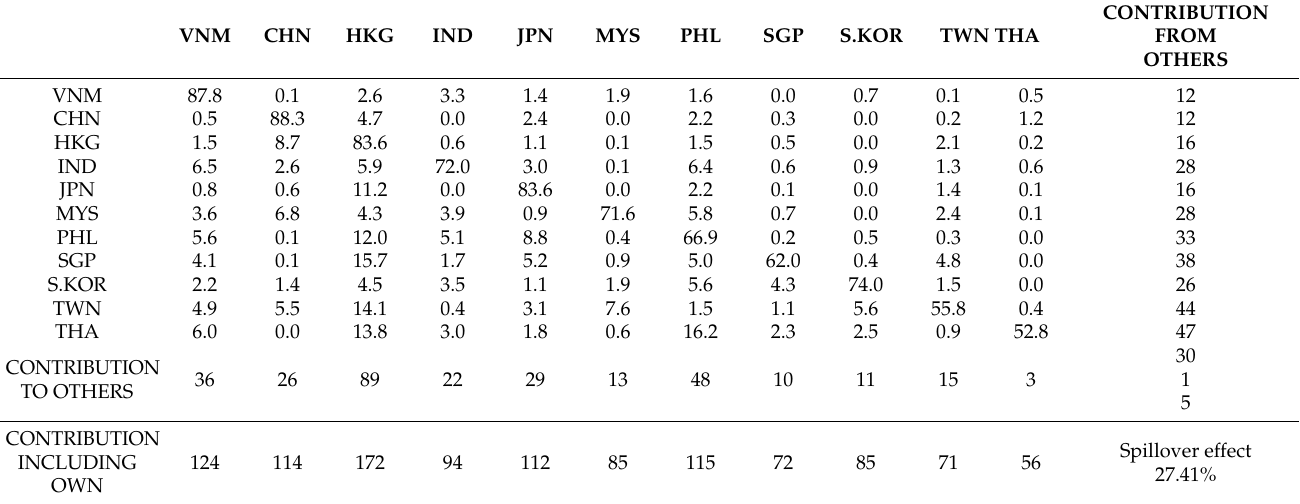
Table 7. The Conditional Volatility